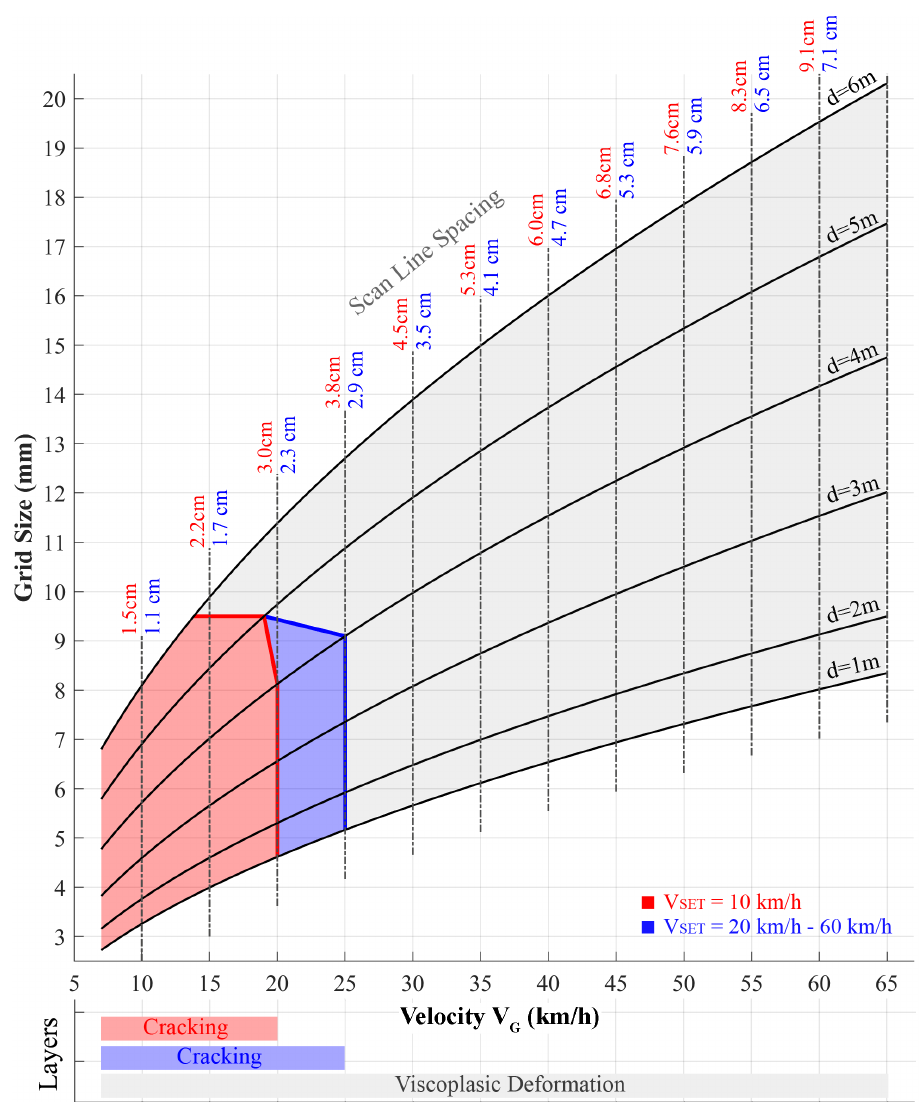
Figure 13. DEM grid size as a function of the velocity V G , of which the density is in turn a function, at various distances d from the MLS trajectory of the MLS, with superimposed domains of quantifiable distress.